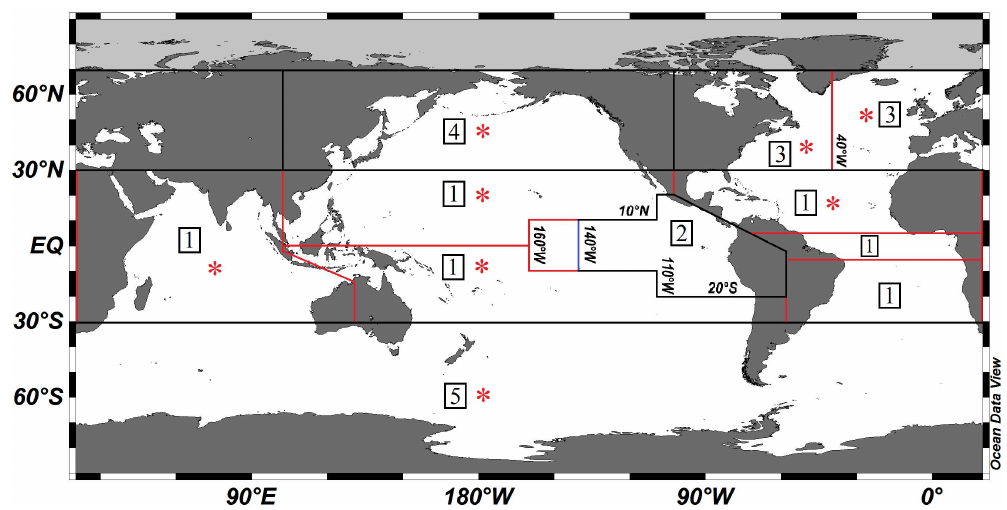
Fig. 3. Spatio-temporal division of the global training dataset for the ad hoc MLR approach. Black boundaries are common for both C T and A T models, while red boundaries are for C T only and blue for A T only. A red asterisk indicates that MLRs were developed for both summer (Nov–Apr for austral hemisphere) and winter (May–Oct for austral hemisphere) periods to constrain C T . Boreal summer/winter seasons are